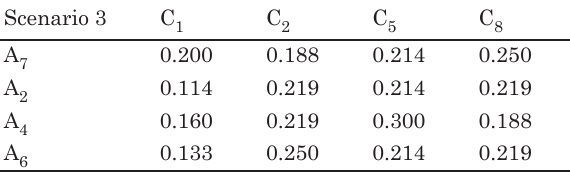
Table 9. Weighted and normalized decision-making matrix for the summarizing part (third scenario) Scenario 3